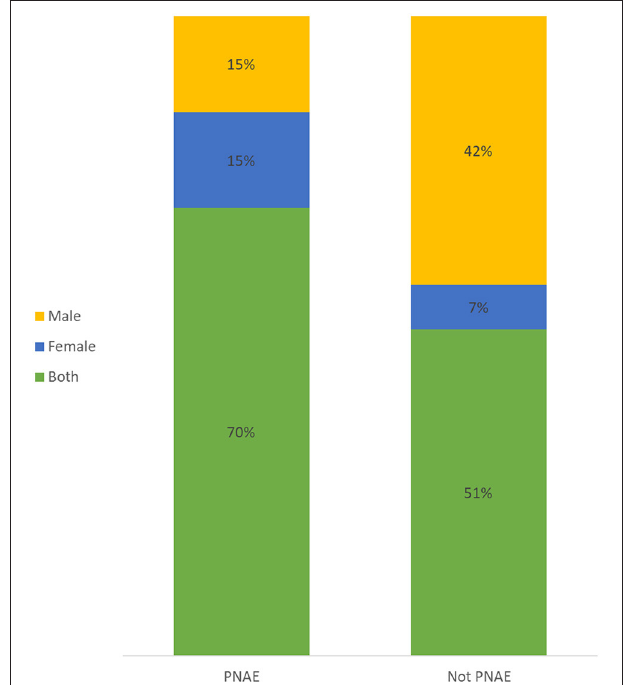
participating, in PNAE, comparing whether male farmers, female farmers, or both (joint management) were the primary decision makers. The overall difference between PNAE and non-PNAE was marginally significant ( p -value =